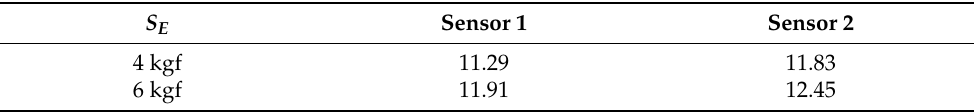
Table 17. Result of sensor data efficiency evaluation for optimal sensor selection of nip force non- Table 18. DNF Number of X, Y, and Z axes from Sensor 2 of nip force non-uniformity fault. uniformity fault.